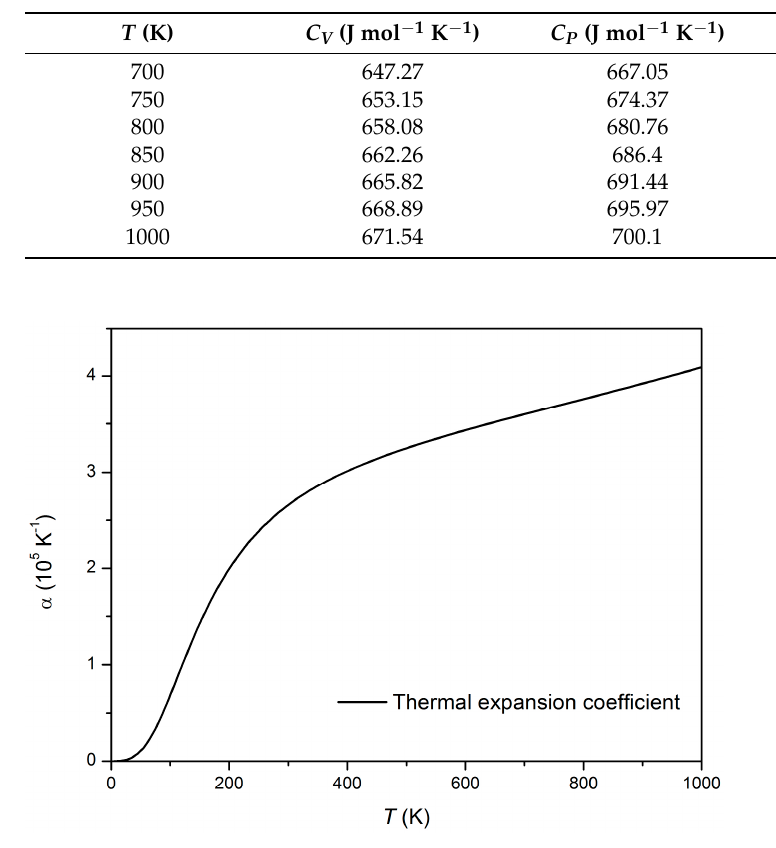
Figure 6. Calculated thermal expansion coefficient of Bre. Table 6. Coefficients of the C P polynomials of Ca 7 MgSi 4 O 16 -Bre ( Pnnm ).